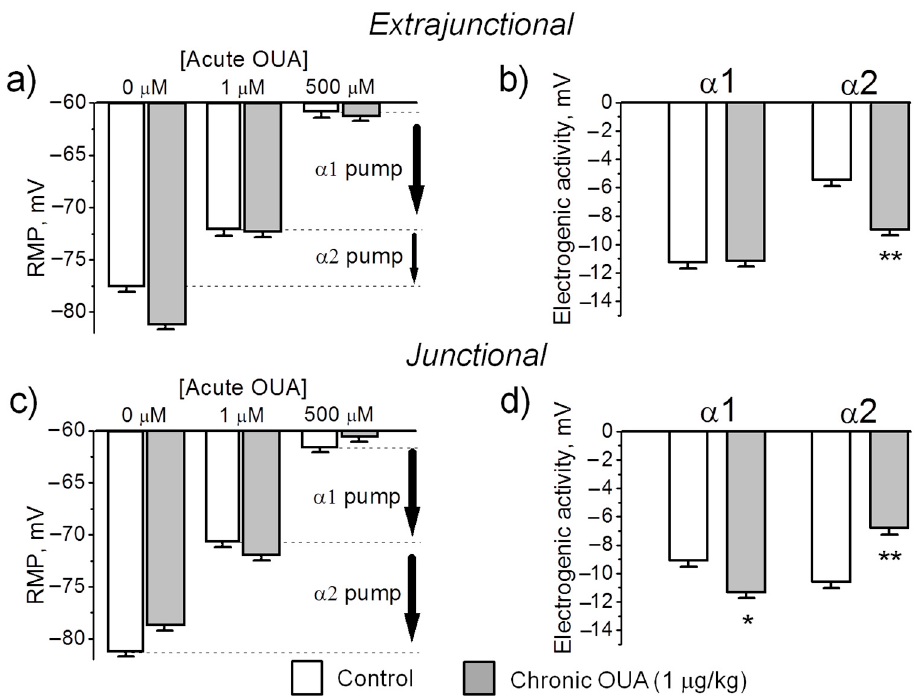
Figure 5. Chronic exposure to 1 µ g / kg ouabain (OUA) for 4 days specifically alters the electrogenic transport by the α 2 Na,K-ATPase isozyme. The RMP and α 1 and α 2 isozyme electrogenic activity were measured in the extrajunctional ( a , b ) and junctional ( c , d ) membrane regions of control (white bars) and ouabain-treated (grey bars) diaphragm muscles. The RMPs were recorded before and 30 min after incubation with 1 µ M ouabain and 500 µ M ouabain (see Methods). Vertical arrows indicate electrogenic contributions generated by the α 1 and α 2 Na,K-ATPase isozymes in control muscles. The RMP reported for each data point represents the mean of measurements of > 150 fibers from muscles of 7 control and 8 ouabain-treated rats. * p < 0.05 and ** p < 0.01 compared with the corresponding control (vehicle treated group).